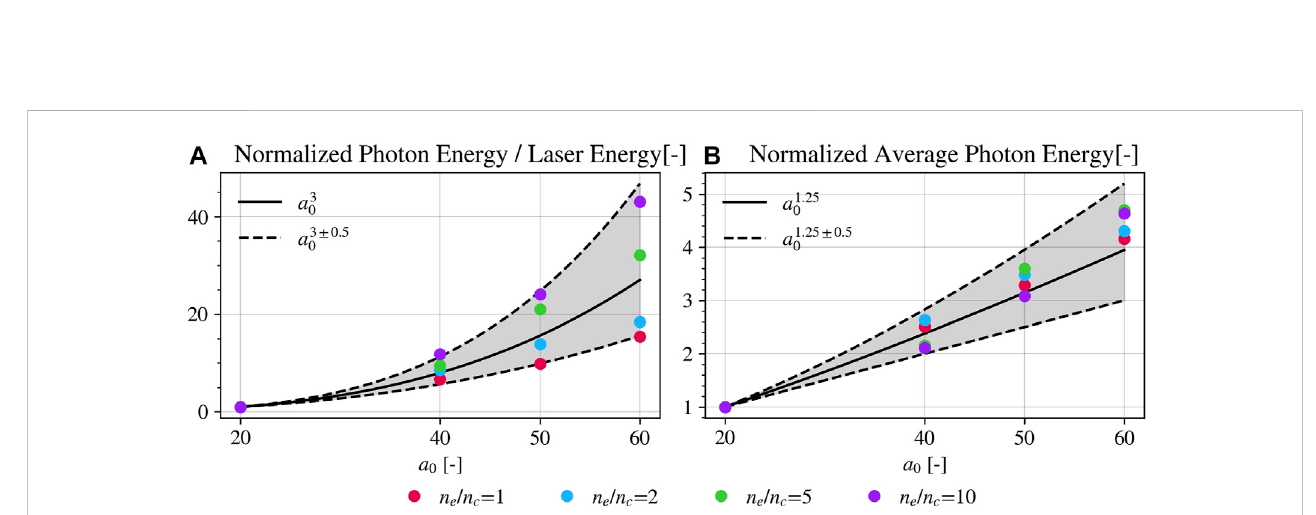
FIGURE 7 Normalized conversion ef fi ciency of photon energy in laser energy (A) and average energy of all emitted photons (B) in the simulations with foam thicknessclosesttotheself-focusinglength f .Normalizationisachievedbydividingbythevalueat a 0 =20once fi xedthefoamdensity n e /n c .Solidanddashed black lines represent powers of a 0 approximately matching the simulation point